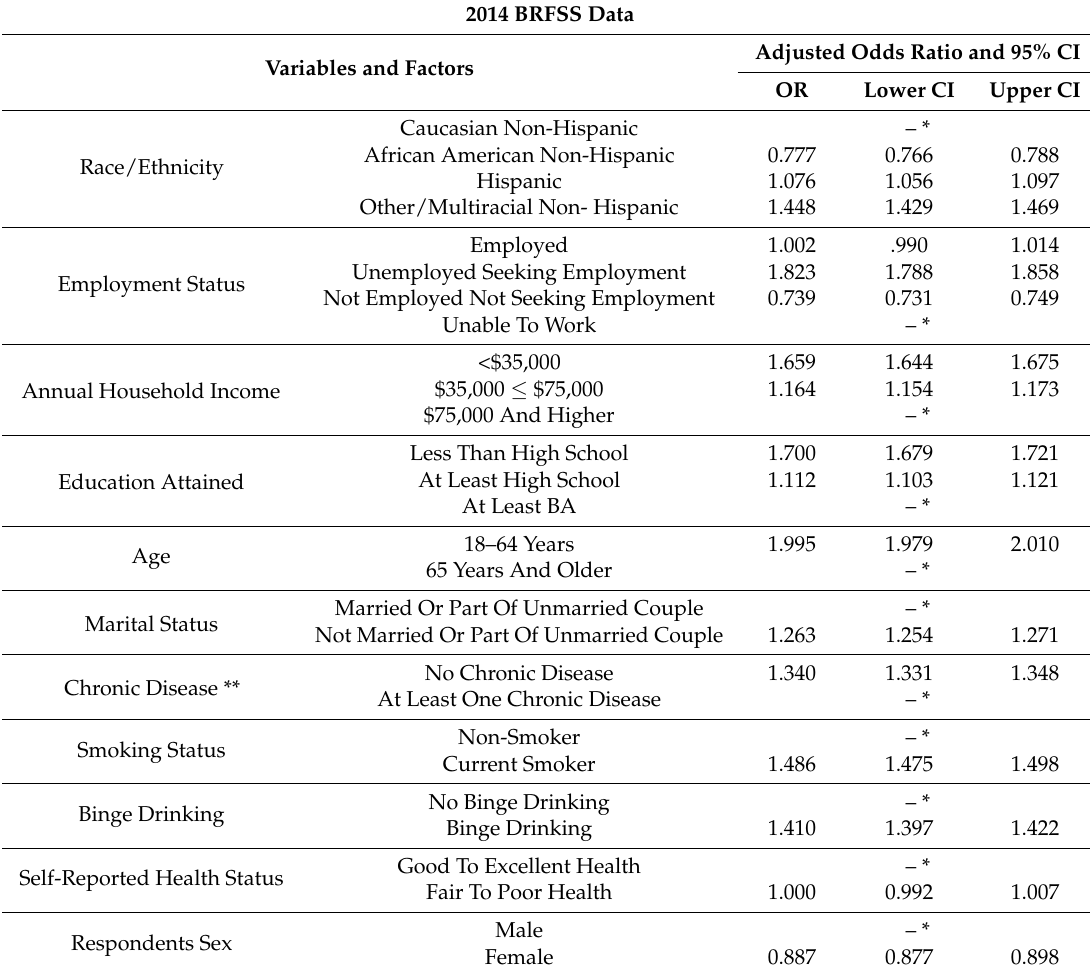
Table 4. Logistic Regression Analysis of Rural US Veterans with Dependent Variable = Health Service Deficits